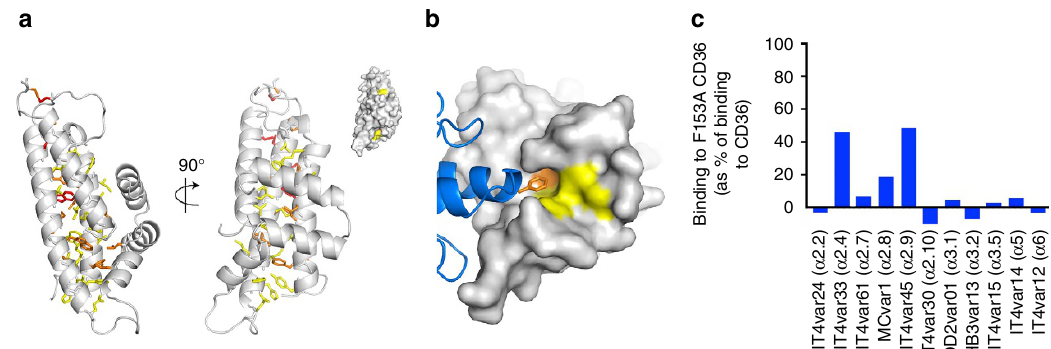
Figure 5 | Limited chemical conservation allows CD36 binding. ( a ) Conservation in the CD36-binding CIDR a domain is plotted onto the structure of the MCvar1 CIDR a 2.8 domain. Absolutely conserved residues are shown as red sticks. Residues with property entropy score of less than 0.1 (but not totally conserved) are orange and those with scores of 0.1–0.3 are yellow. The inset shows a surface representation in the same orientation and colours, showing